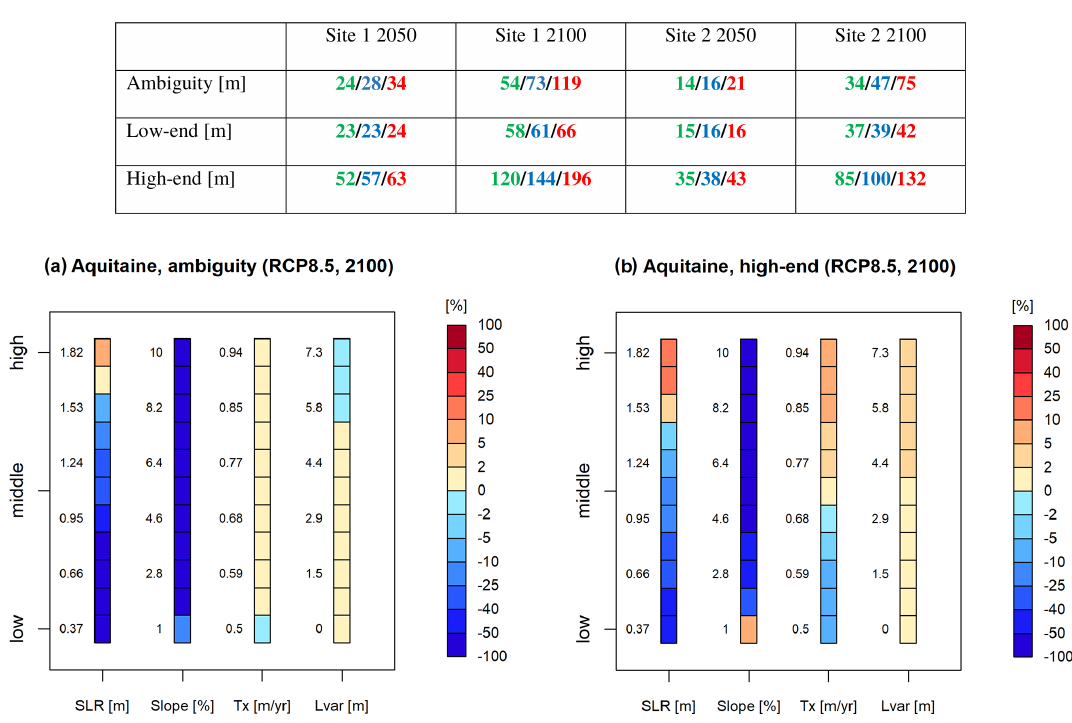
Figure 7. Relative change (in percent) of the p -box ambiguity (a) and high-end estimate (b) when the possibility (or probability) input distribution of one of the terms in Eq. (1) (i.e. SLR, Tx) is pinched to a fixed value. For each term, 11 values are pinched at a regular interval from the lower to the upper range of the possibility (or probability) distribution. These pinched values are specified on the left side of each bar plot. Site 1 is